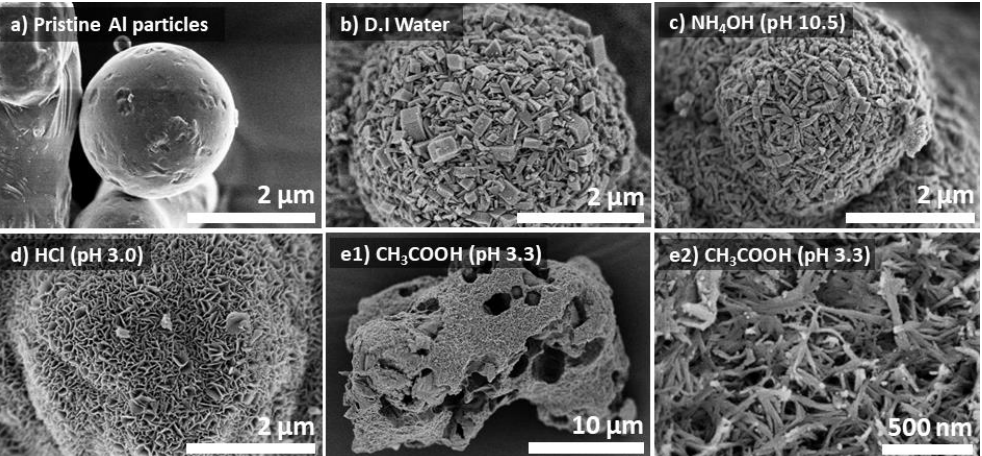
Figure 2. SEM micrographs of the pristine Al particles ( a ) and the Al@AlOOH core–shell structures prepared by HTR in D.I.-H 2 O ( b ), and aqueous solution of NH 4 OH ( c ) and HCl ( d ). The sample prepared in aqueous solution of CH 3 COOH ( e1 , e2 ) did not show the construction of a Al@AlOOH core–shell structure.